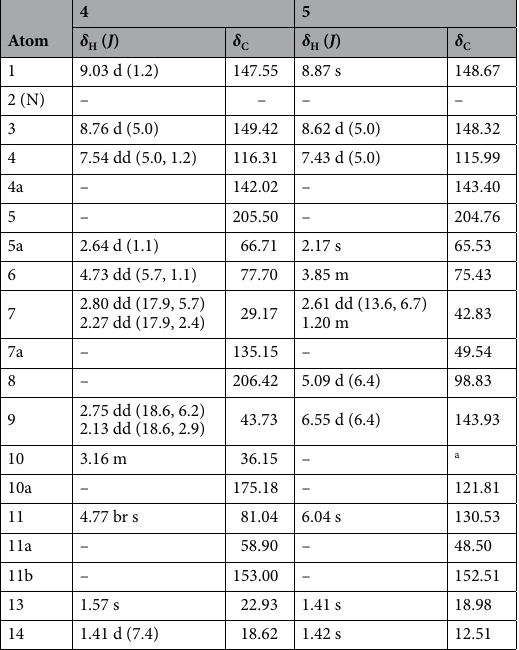
Table 2. 1 H and 13 C NMR data of compounds 4 and 5 in CDCl 3 , ( δ in ppm, J in Hz). a Signal not visible due to extreme line broadening.